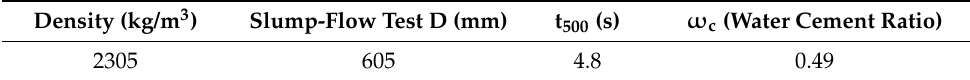
Figure 3. ( a ) Slump-flow test; ( b ) Concrete cubes and cylinders. Table 3. The test results obtained on fresh concrete.